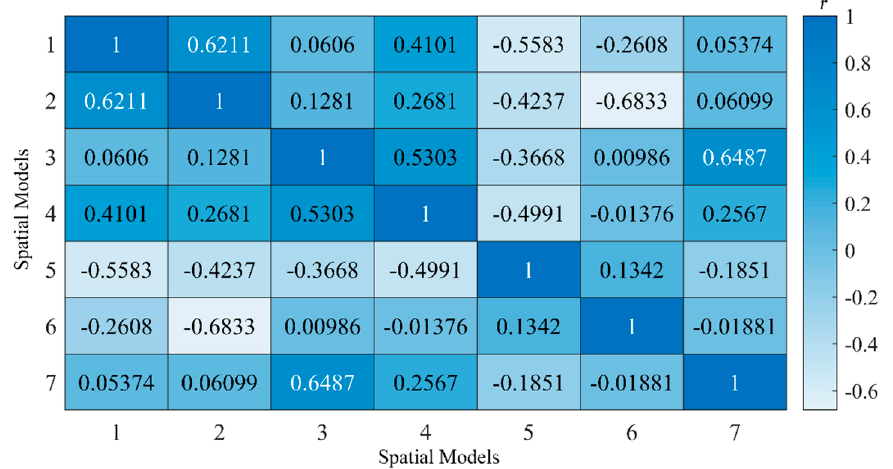
Figure 5. The correlation of drought variability for different spatial modes in the North China Plain.